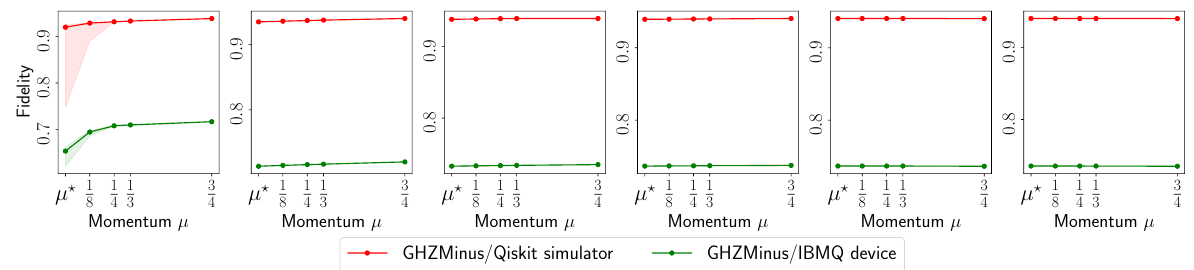
Figure A7. Convergence iteration plots for reconstructing GHZ ments from IBM Quantum system experiments and synthetic measurements from Qiskit simula- tion experiments.